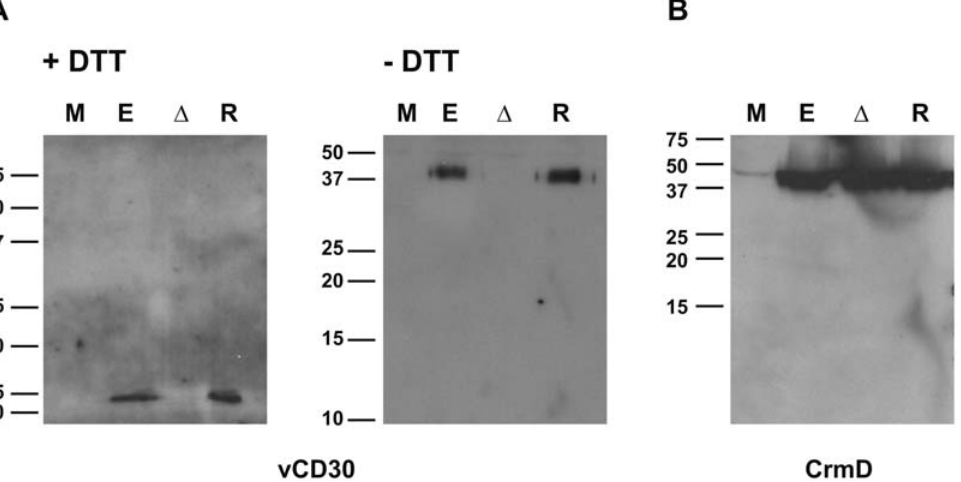
Figure 4. ECTV vCD30 forms disulfide linked trimers. Western blot analysis using anti vCD30 (A) or anti CrmD (B) antibodies of supernatants from mock-infected BSC-1 cells (M) or cells infected with ECTV (E), ECTV D CD30 ( D ) or ECTVRevCD30 (R).